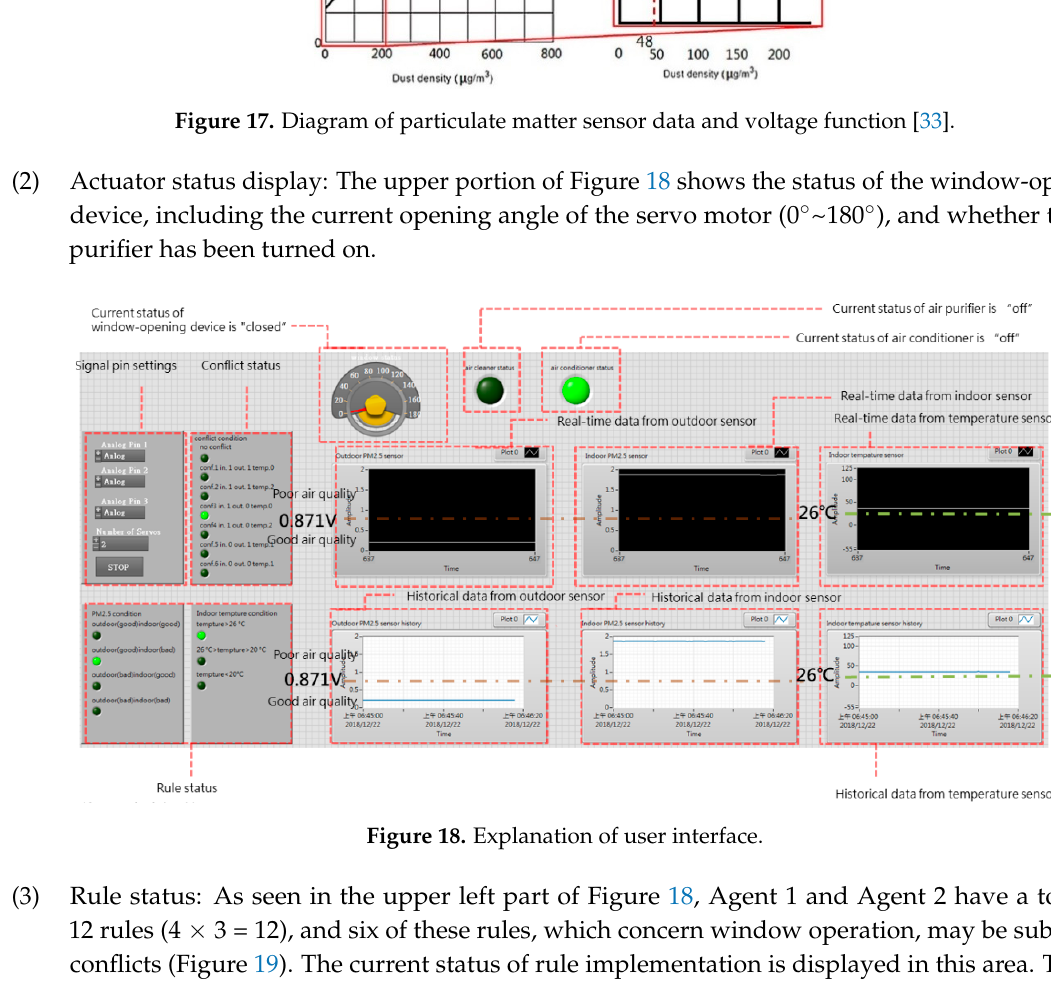
Figure 18. Explanation of user interface.